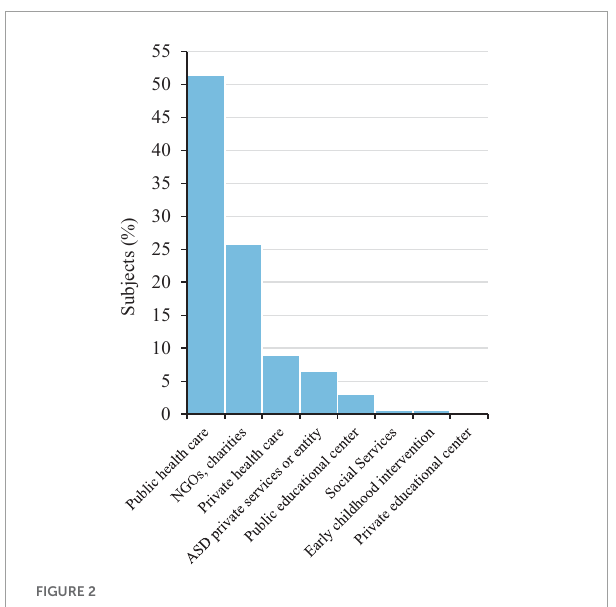
FIGURE2 Location of diagnosis of the study participants ( N = 2,563). NGO, non-governmental organization.